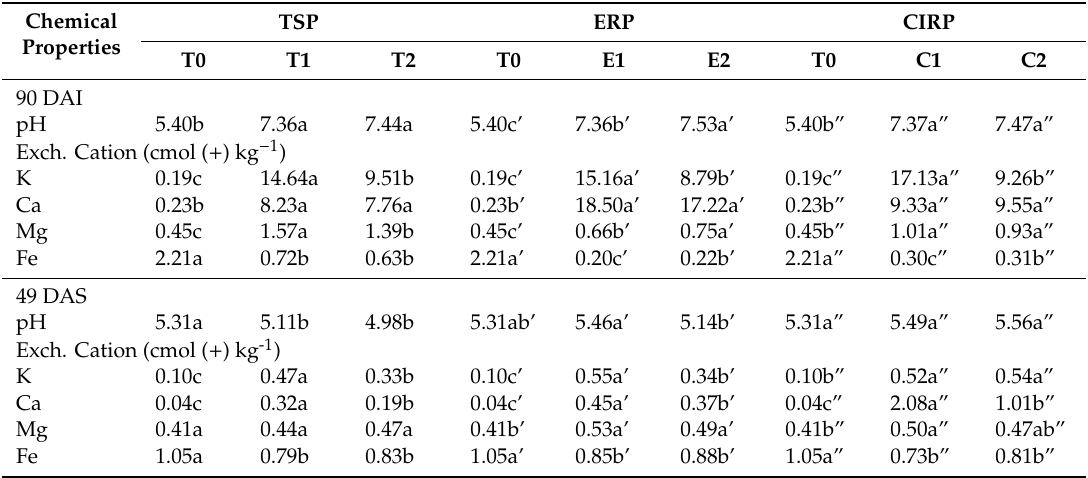
Means within row with different letters indicate significant difference using Tukey’s test at p ≤ 0.05. The '±’ indicates standard error of quadruplicates, whereas Exch. is exchangeable.